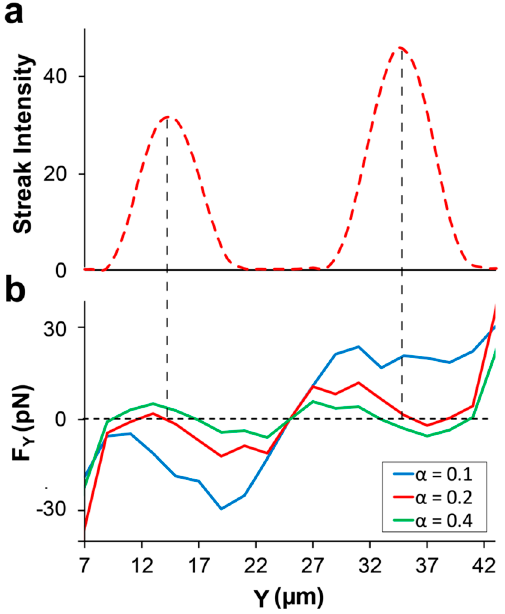
Figure 9. Effects of fluid shear-thinning on the prediction of focusing position. ( a ) Experimental results for the streak intensity of the 7.32 µm diameter particles in 1000 ppm PEO at Q = 5 µL/min ( Wi = 18). ( b ) Simulation results for three different alpha constants. The α = 0.2 predicts the focusing positions precisely, while overestimating shear-thinning extent of the fluid ( α = 0.4) predicts focusing positions closer to the channel center, and underestimating alpha ( α = 0.1) predicts no focusing in the central regions.